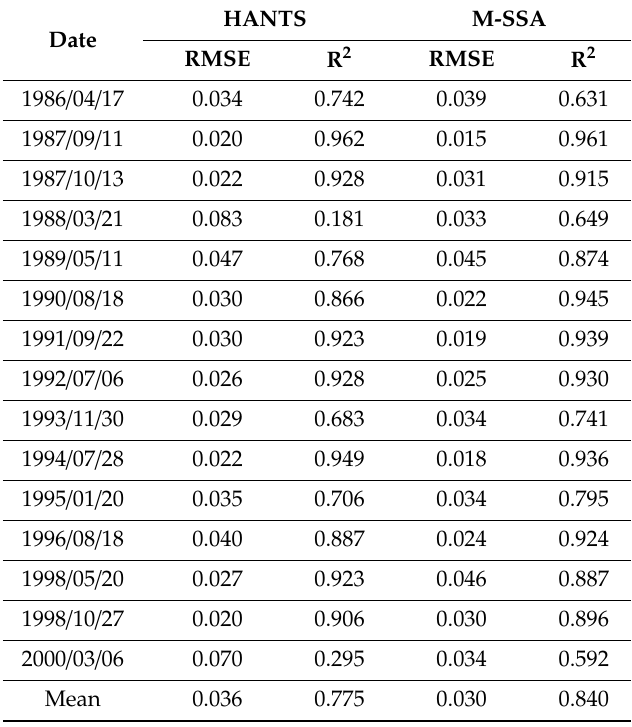
Table 2. RMSE and R 2 between 15 random images extracted and reconstructed by the HANTS and M-SSA